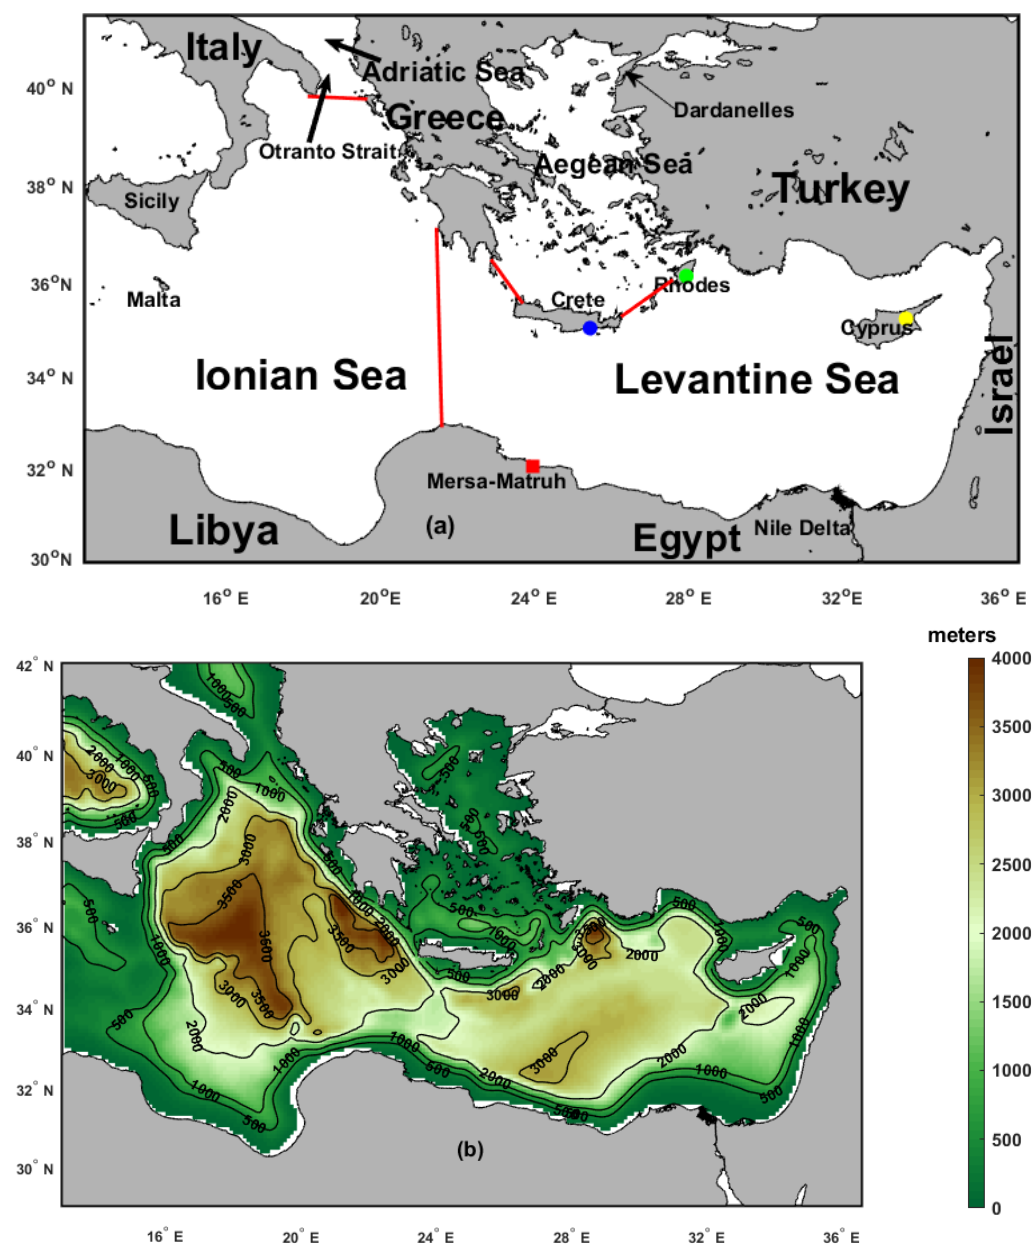
Figure 1. ( a ) The Eastern Mediterranean Sea with the main geographic features (e.g., Basins) where, the solid red square is the position of Mersa Matruh City, the solid blue circle is the position of Crete, the solid green circle is the position of Rhodes, the solid yellow circle is the position of Cyprus and the solid continuous red lines delineate the boundaries between EMED basins. ( b ) Bathymetry according to GEBCO bathymetric dataset (https://www.gebco.net/ (accessed on 20 March 2021)) with 10 m as the minimum depth.